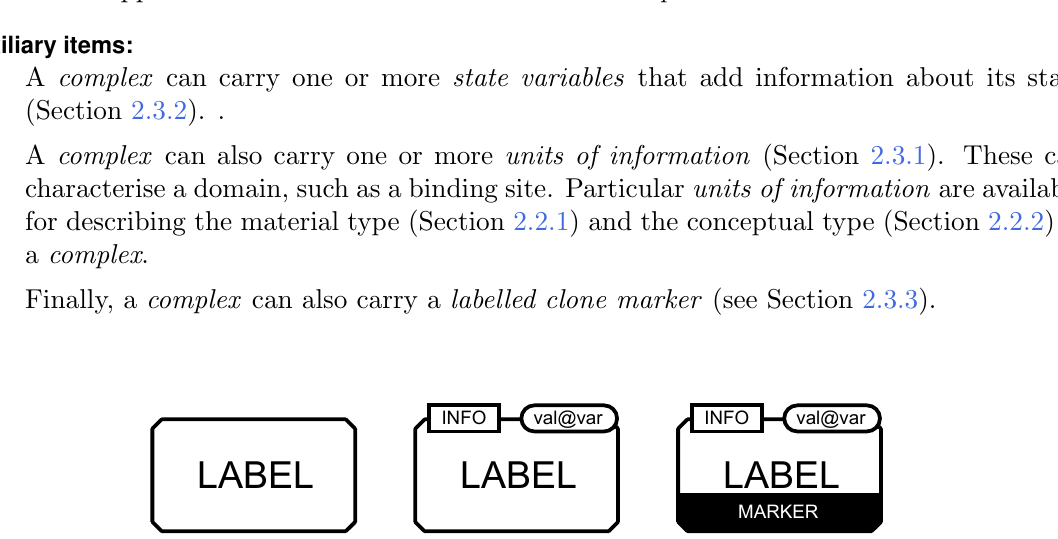
Figure 2.14: The Process Description glyph for complex , shown plain and unadorned on the left, with an additional state variable and a unit of information in the middle, and with a labelled clone marker on the